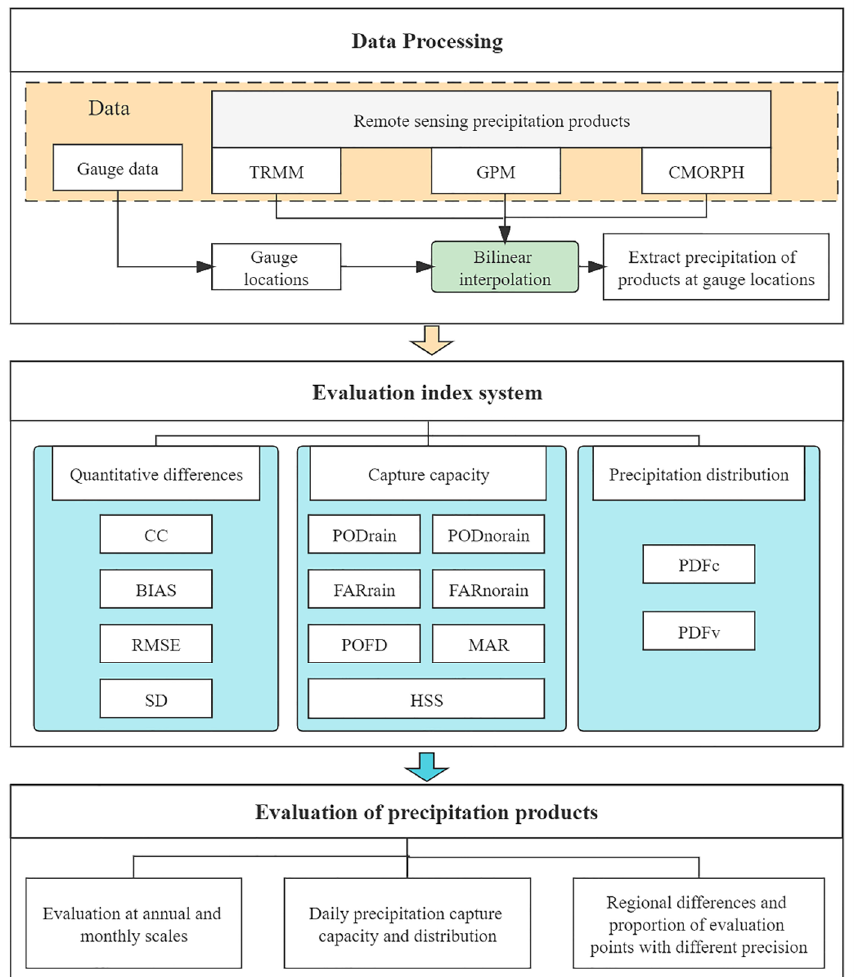
Figure 4. Flowchart of evaluation of remote sensing precipitation products.